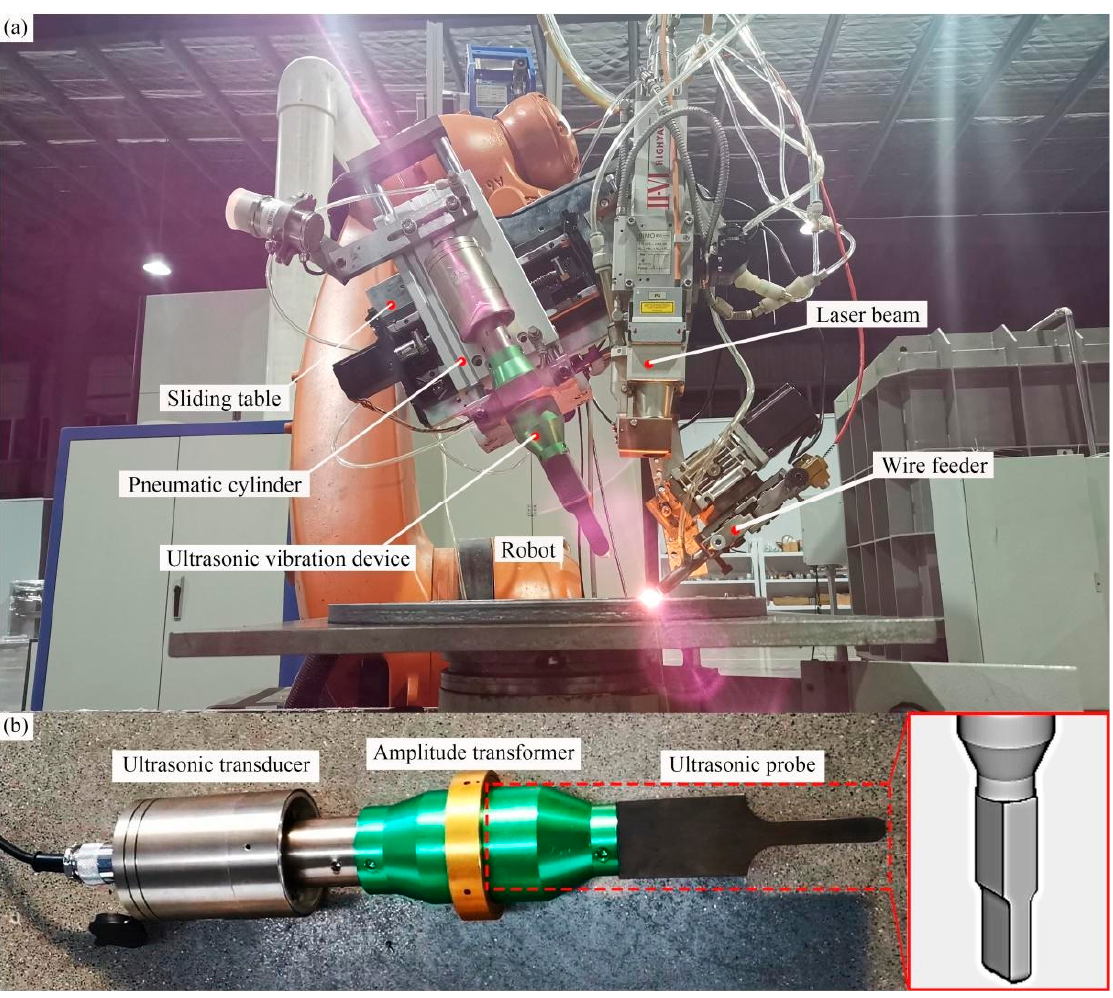
Figure 3. Set-up for LWAM assisted with ultrasonic vibration: ( a ) overall arrangement diagram; ( b ) an ultrasonic vibration device, reproduced or adapted from [70], with permission from Elsevier, 2021.